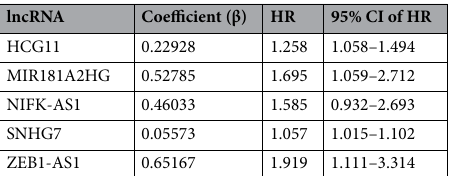
Table 2. Multivariate Cox results of lncRNAs based on TCGA data. HR hazard ratio, CI confidence